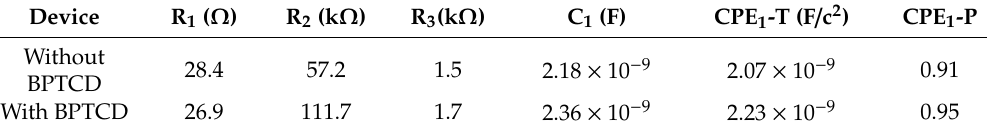
Table 3. Parameters of the equivalent circuit for PePDs with and without BPTCD additive.